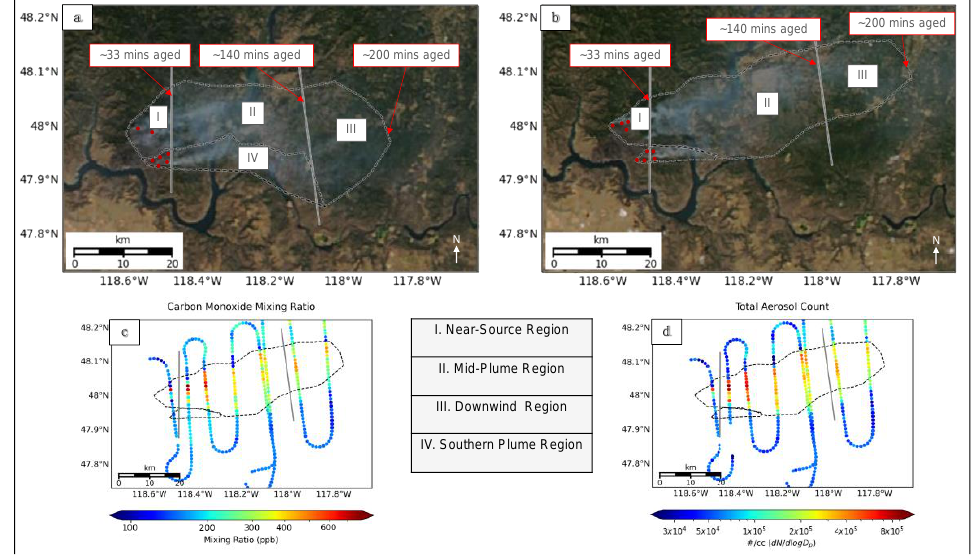
Figure 1. The Williams Flats Fire as seen on 06 August 2019: ( a ) at Multi-Angle Imaging Spectrometer (MISR) overpass time (19:06 UTC; MODIS Terra RGB image), and ( b ) during the Fire Influence on Regional to Global Environments Experiment-Air Quality (FIREX-AQ) flight operations (20:50 UTC; MODIS Aqua RGB image). The red dots indicate MODIS-identified hot spots, used to estimate source location. The dashed lines represent plume outlines we use for analysis. At both observation times, the plume is divided into distinct regions (I-III) based on estimated plume age, to allow for easy, qualitative comparison of inter- and intra-plume properties. At the time of MISR observation, there is an additional region (IV) that separates the southern-most plume from the other regions. The differential absorption CO measurements instrument (DACOM) CO mixing ratio and the laser aerosol spectrometer (LAS) total aerosol concentration observed by the aircraft (above 0.09 µm in diameter) are displayed in ( c ) and ( d ), respectively.